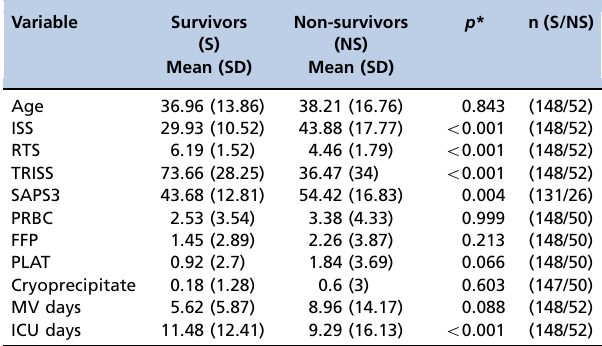
Table 1 - Comparison of quantitative variables between the survivor and non-survivor groups. Variable Survivors